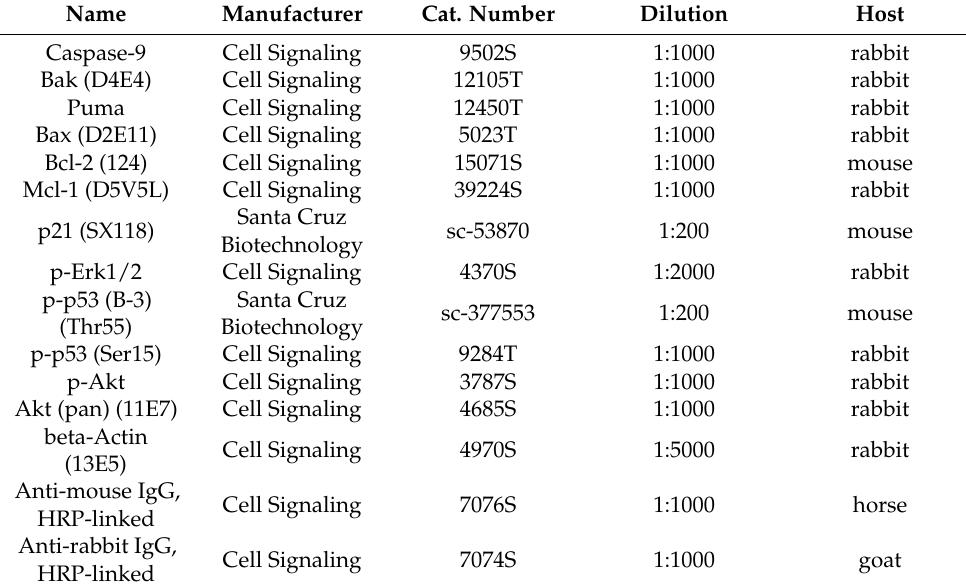
Table 1. Specifications and dilutions of the applied primary and secondary